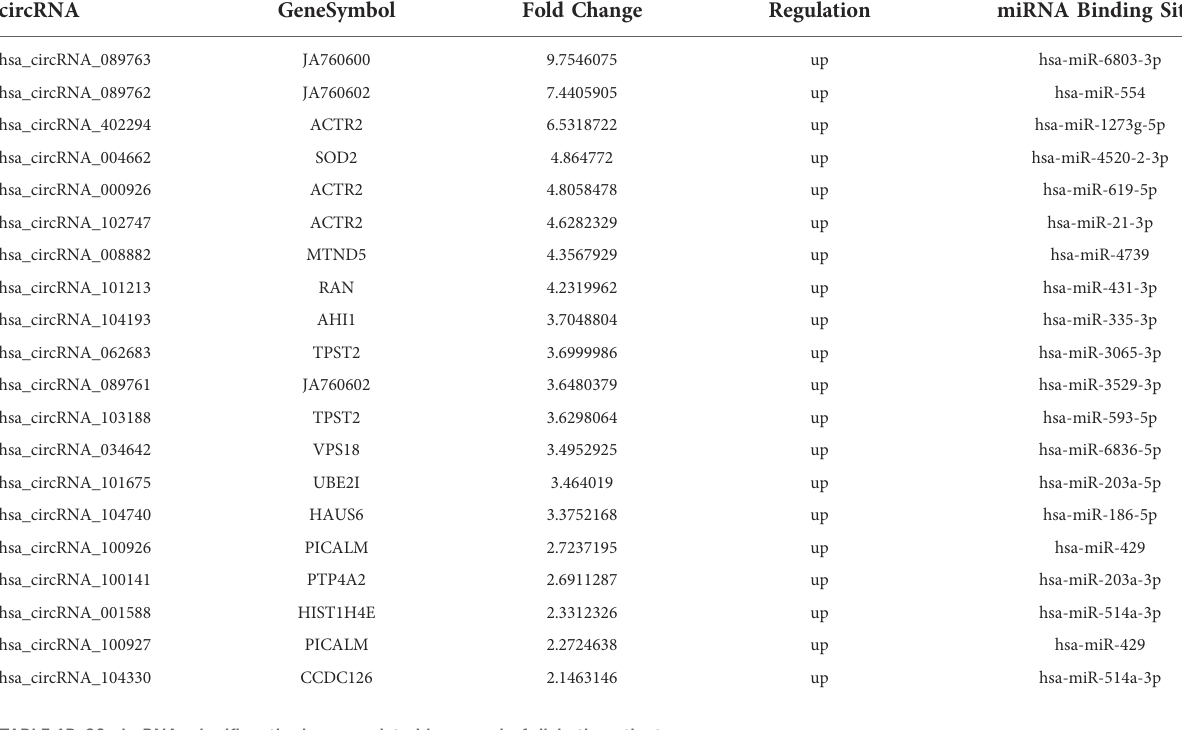
TABLE 1A 20 circRNAs signi fi cantly upregulated in wound of diabetic patients.